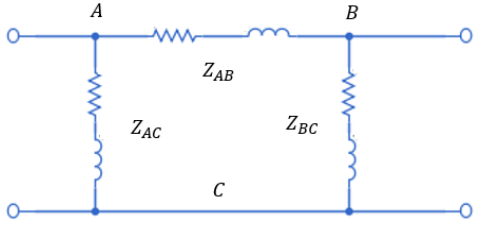
Figure 3. Equivalent model of the damaged line.